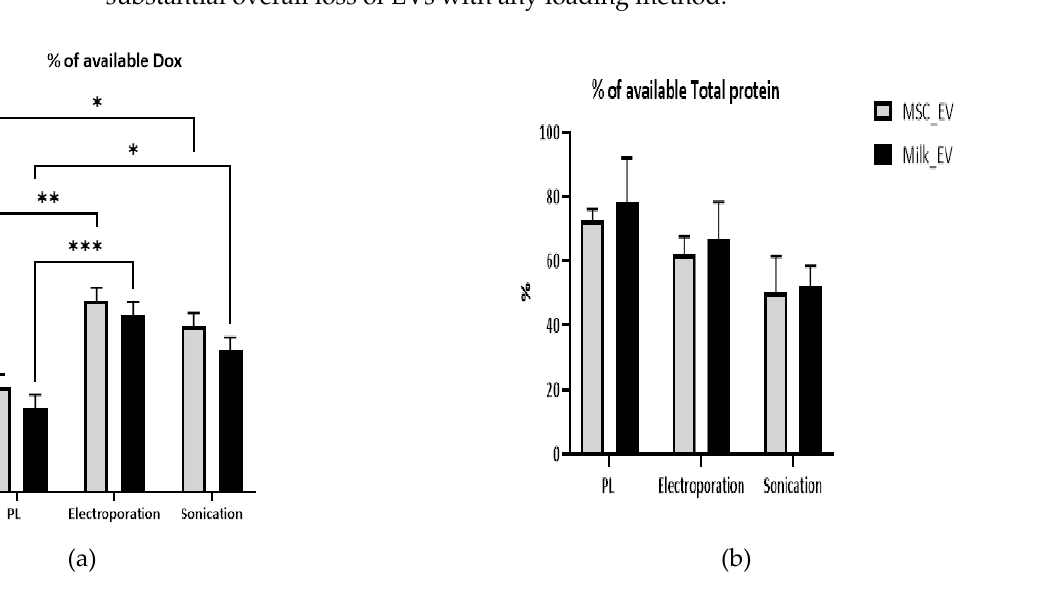
Figure 3. ( a ) Percentage of Dox that was made available and that was apparently loaded into the MSC EVs or milk EVs following passive loading (PL), active loading by electroporation (ALE), or active loading by sonication (ALS). ( b ) Percentage of total protein remaining post-loading by PL, ALE, and ALS, where the total protein was used as a surrogate for EVs quantities. Results are mean from n > 3 ± SEM biological repeat experiments. A 2-way Anova analysis was performed; * represents p value < 0.05, ** p < 0.01, and *** p < 0.001.